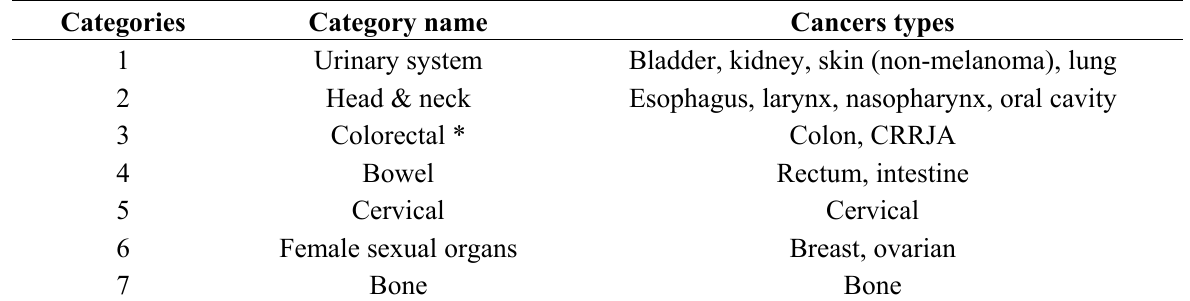
Table 2. Given the appropriate name of each cancer category.